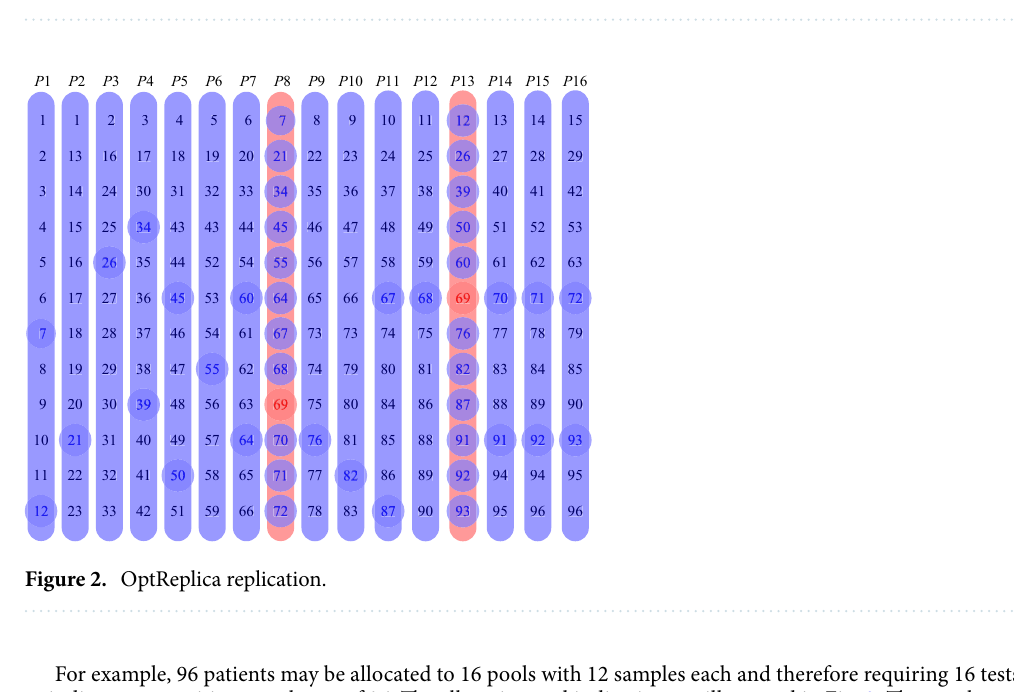
Figure 1. Transposition based replication.